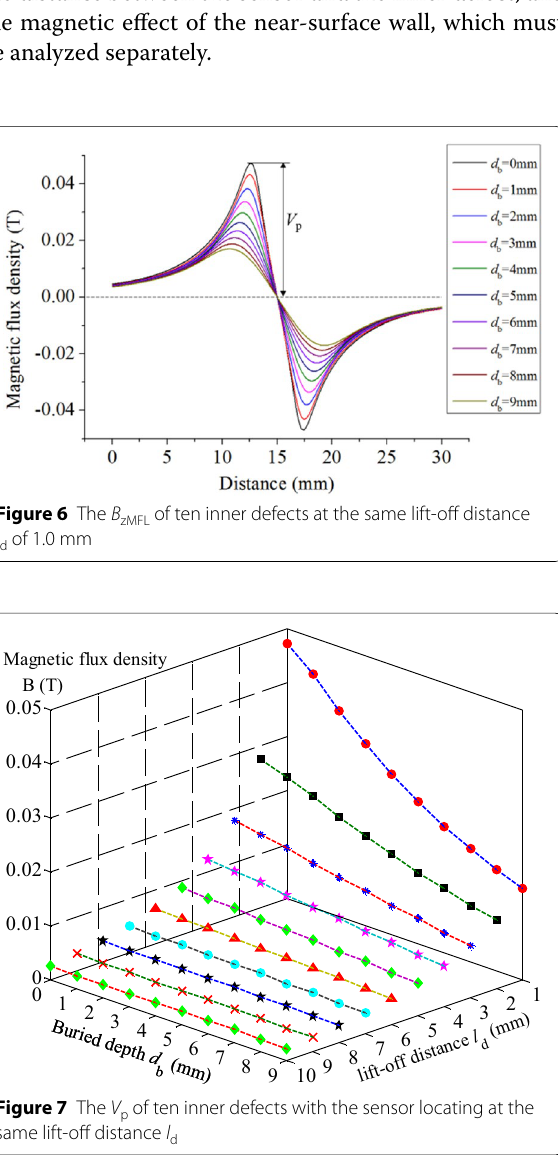
Figure 7 The V p of ten inner defects with the sensor locating at the same lift-off distance